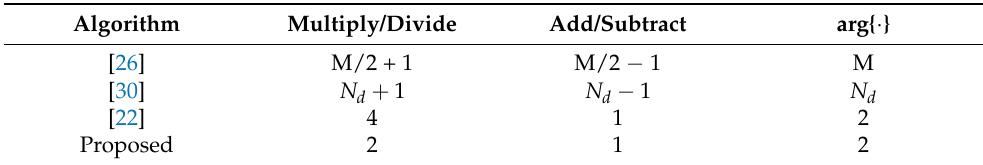
Table 4. Complexity comparisons of SFO